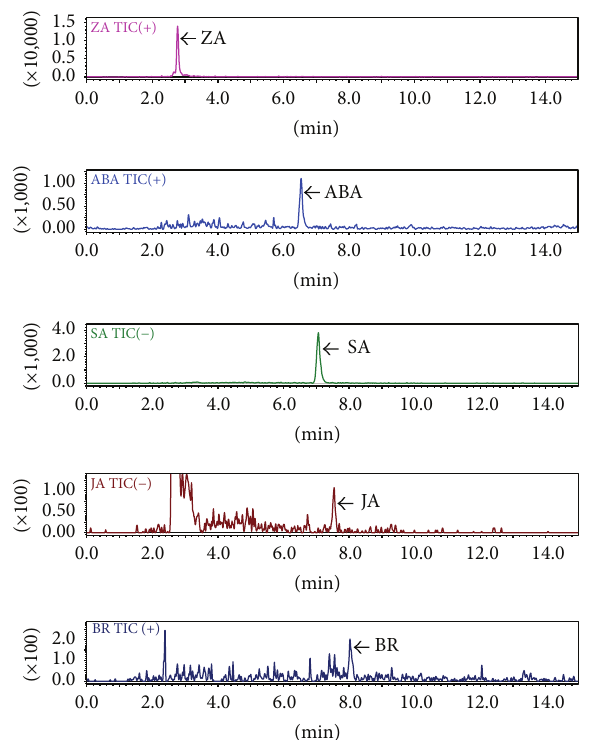
Figure 3: Typical MRM chromatograms of zeatin (ZA), abscisic acid (ABA), salicylic acid (SA), jasmonic acid (JA), and brassinolide (BR) in the crude extract of A. thaliana rosette